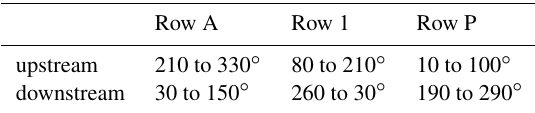
Table 2. Wind direction ranges for SAR/SCADA comparisons for upstream and downstream